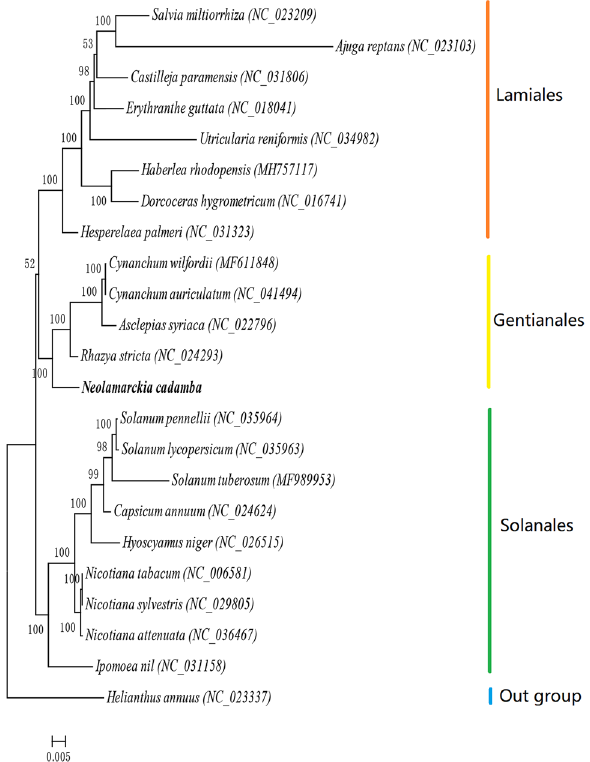
Figure 3. Maximum likelihood tree based on the sequences of 24 PCGs from the mitochondrial genomes of 23 species. The values on branch nodes represent the supporting rates (percentages) derived from 1000 bootstrapping